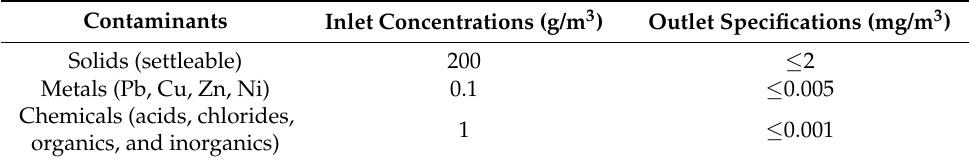
Table 2. Municipal case study contaminants and purity constraints for GAMS modeling.